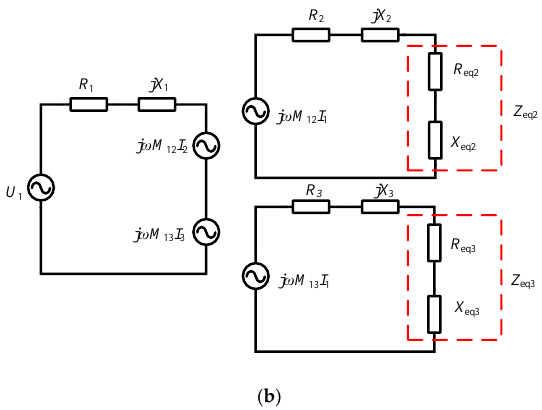
Figure 1. Schematic and equivalent circuits of two-receiver WPT system: ( a ) schematic circuit of two-receiver WPT system; ( b ) equivalent circuit of two-receiver WPT system.